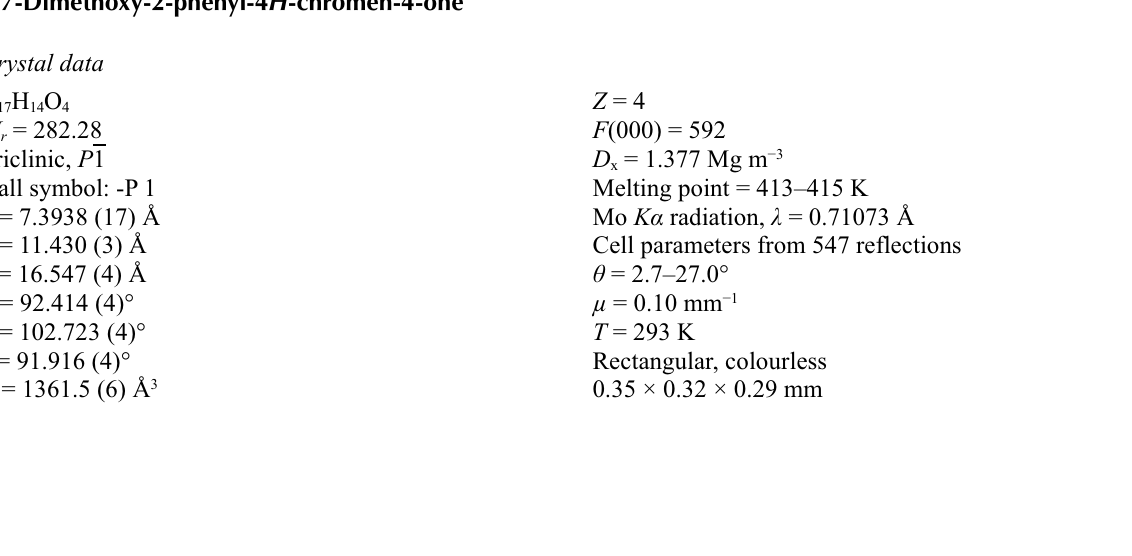
Figure 2 Part of the crystal structure viewed along the a -axis. Dashed lines represent weak C–H···O interactions. 5,7-Dimethoxy-2-phenyl-4 H